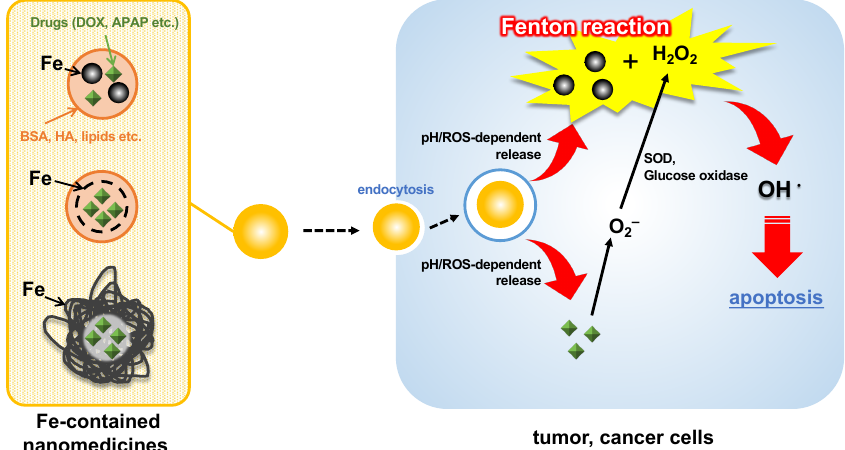
Figure 4. Depicted representative scheme of cell apoptosis by Fe-containing nanomedicines via the Fenton reaction. DOX, doxorubicin; APAP, amionoacetophen; BSA, bovine serum albumin;